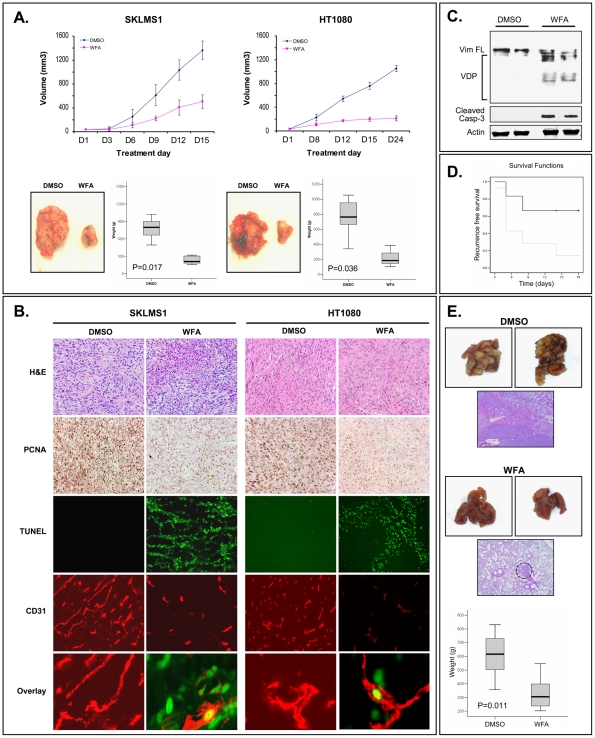
WFA abrogates STS growth, angiogenesis, recurrence, and metastasis in vivo.

 A) WFA (2 mg/kg) significantly inhibits STS local growth and tumor weight; B) WFA treatment decreases tumor cell proliferation (PCNA), enhances apoptosis (TUNEL), and inhibits STS associated angiogenesis (CD31). CD31 (red)/TUNEL (green) double immunofluorescence analysis demonstrating apoptotic endothelial cells in WFA-treated tumors; C) WB analysis of tissue samples demonstrating vimentin degradation and caspase-3 activation in WFA-treated tumors; D) Kaplan Meier curves demonstrating a statistically significant (P = 0.02) delay in SKLMS1 local recurrence in WFA treated mice (black curve) compared to control (gray curve); E) Control mice (DMSO treated) exhibit numerous large MPNST lung metastases almost completely replacing the lung parenchyma. In contrast, WFA-treated mice exhibit markedly fewer microscopic small lung nodules (circle). WFA treatment significantly decreases average lung weights as compared to controls (box plots). (Vim FL  =  full length vimentin; VDP  =  vimentin degradation products).